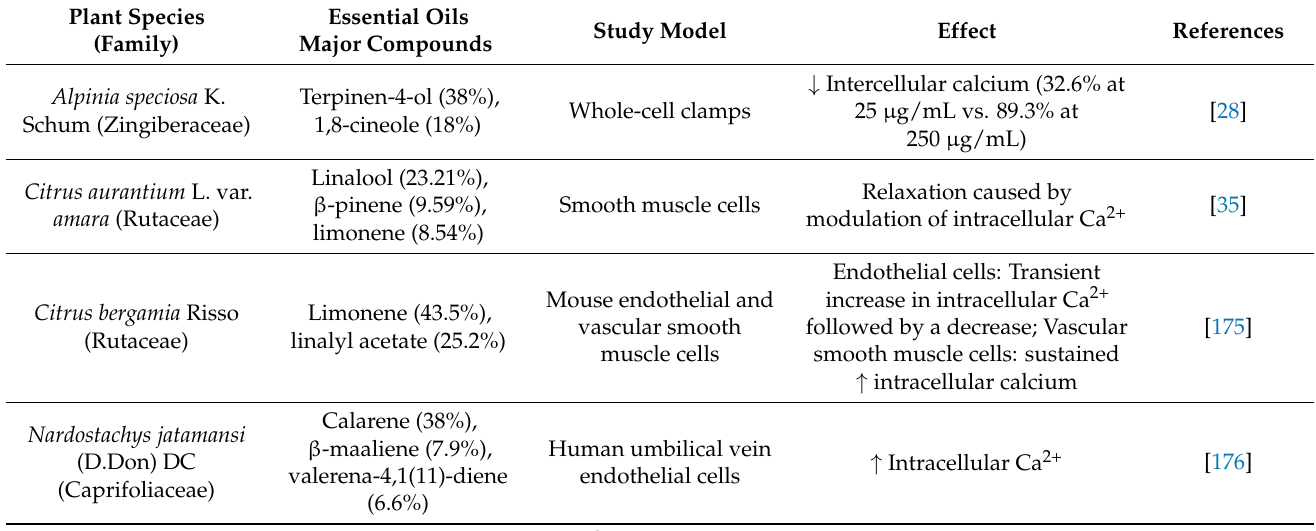
Table 4. Ion channel modulation by essential